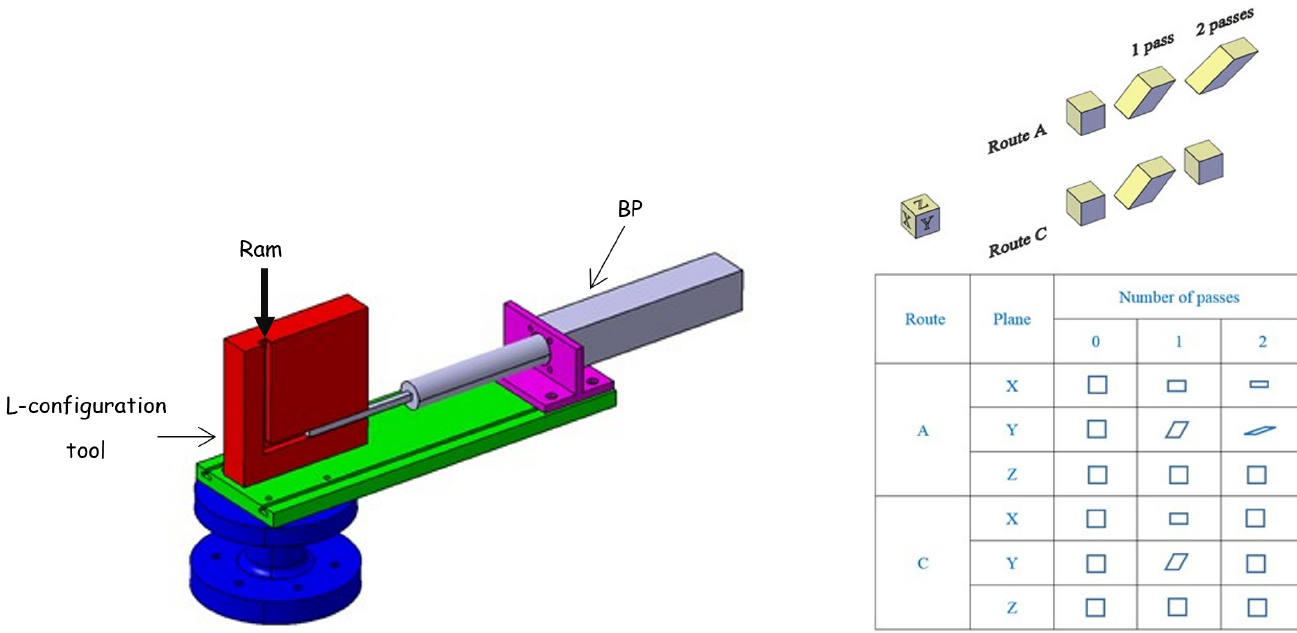
Figure 1. Schematic illustration of the L-configuration ECAE facility (90° die-angle tooling) equipped with BP and deformation after one extrusion and two extrusions via routes A and C (X: Transverse plane, Y: Flow plane, Z: Longitudinal plane).